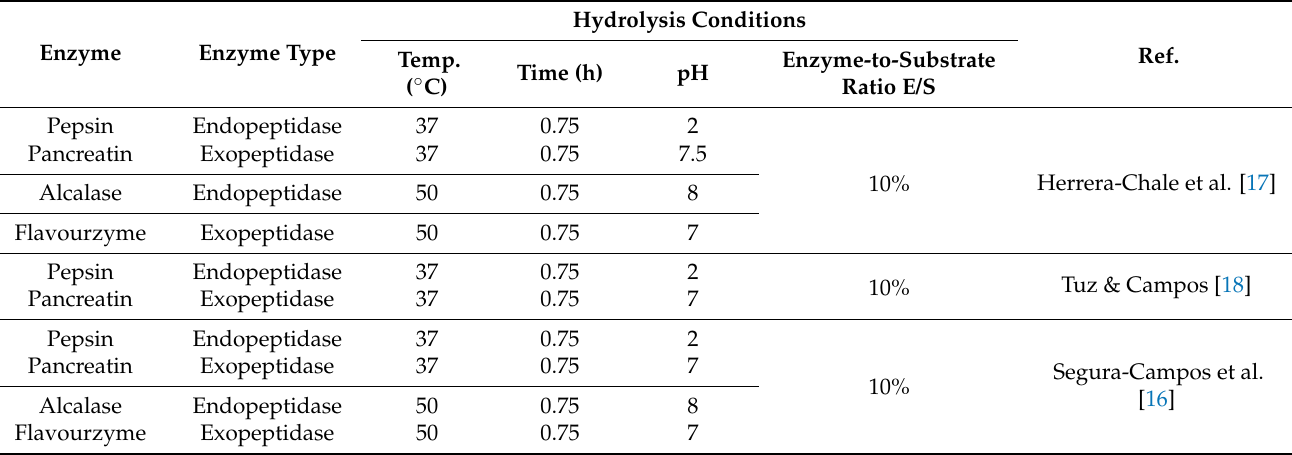
Table 2. Enzymatic hydrolysis conditions of velvet bean protein concentrate to produce ACEi